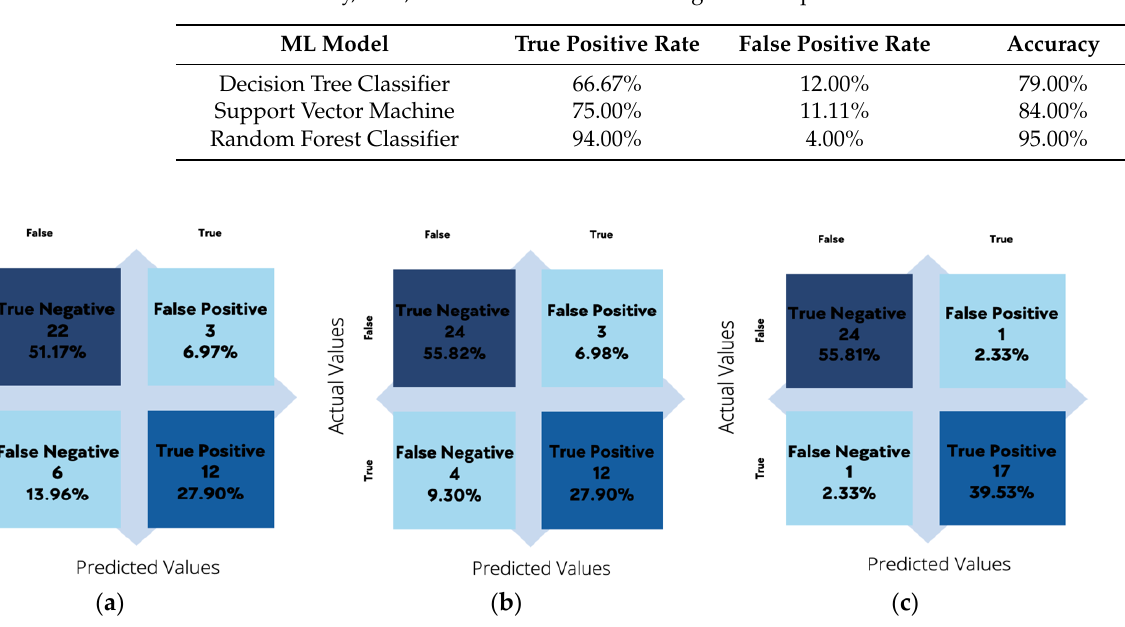
Figure 4. Confusion matrix for ML algorithms. ( a ) DT confusion matrix; ( b ) SVM confusion matrix; ( c ) RF confusion matrix.